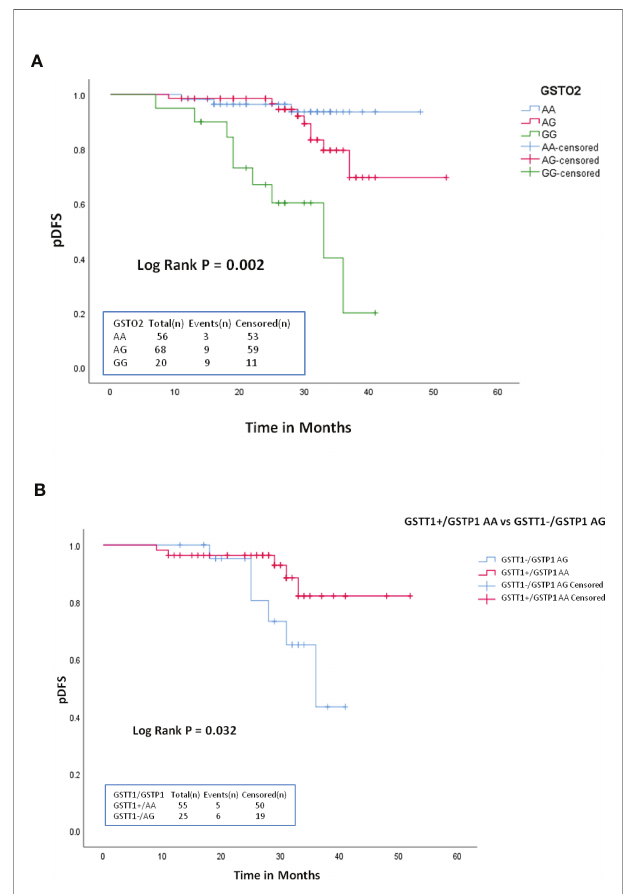
FIGURE 2 | Kaplan-Meier survival plots strati fi ed according to: (A) GSTO2-AA vs GSTO2-AG and GSTO2-GG (B) GSTT1+/GSTP1-AA vs GSTT1+/GSTP1-AG with respect to probability of disease free survival (DFS) during